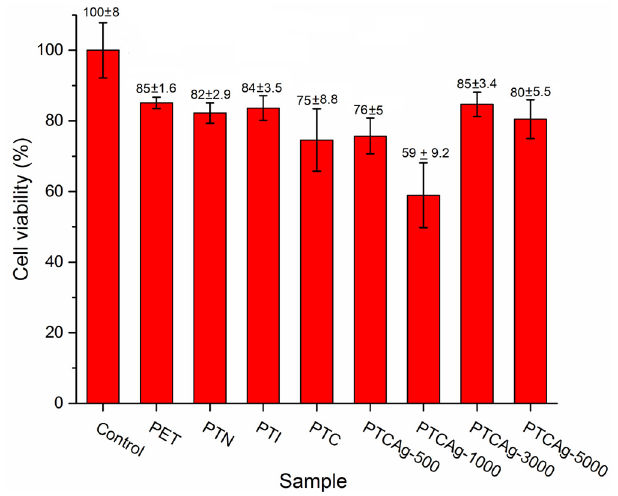
Figure 9. Cell viability along the grafting process (PET, PETN, PETI, and PETC) and silver-loaded PETC with different silver nanoparticles percentages (PETAg-500 (1.2 ± 0.4%), PETAg-1000 (2.1 ± 0.6%), PETAg-3000 (6.3 ± 1.3%), and PETAg-5000 (7.1 ± 1.4%)).